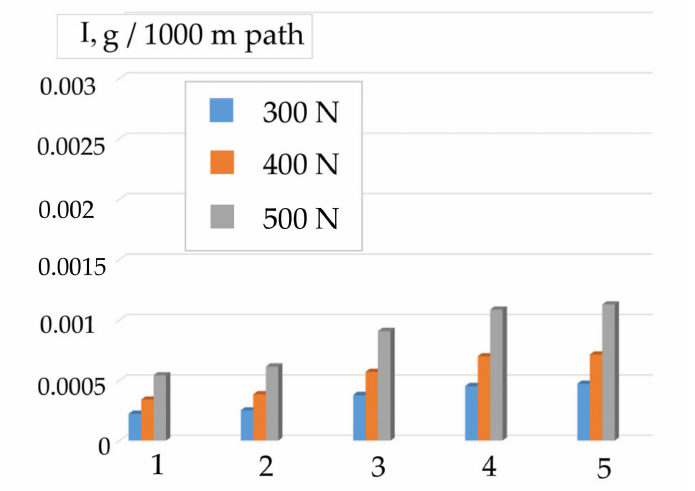
Figure 4. The reduced wear of steel 45. LCL with concentration: 1—1%; 2—5%; 3—3%.